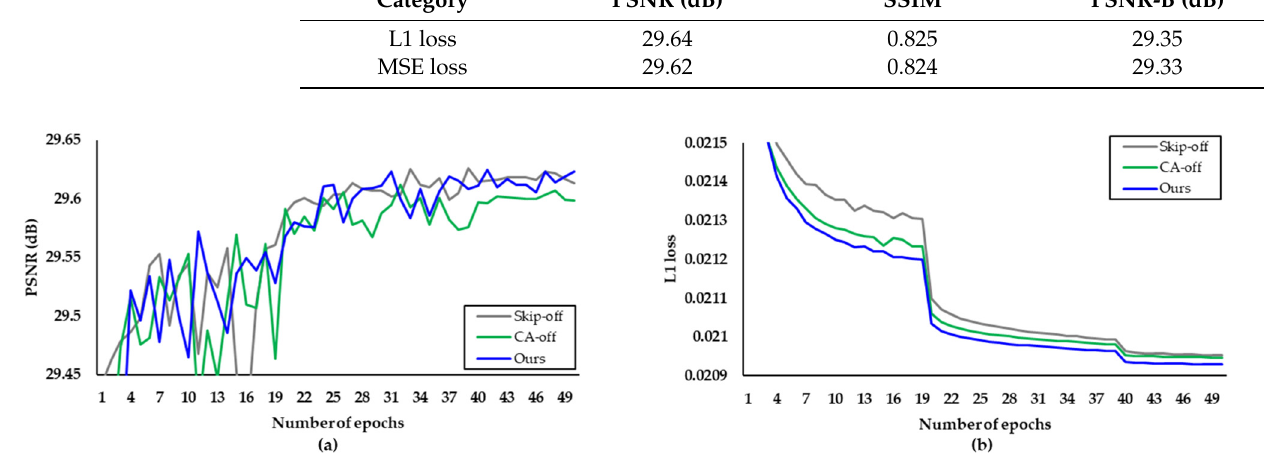
Figure 5. Verification of the skip connection off (skip-off), channel attention blocks off (CA-off) and proposed method in terms of AR performance. ( a ) PSNR per epoch. ( b ) L1 loss per epoch.